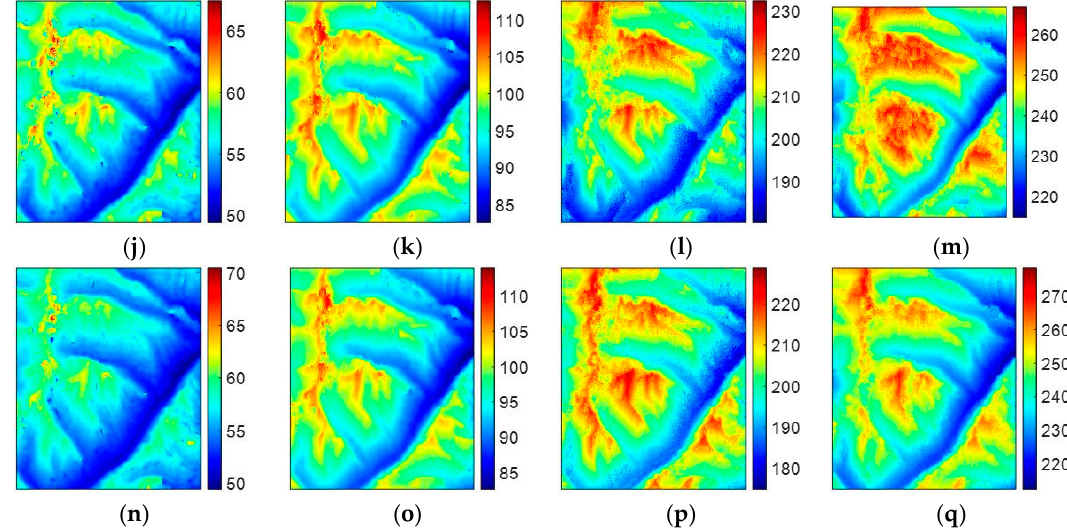
Figure 7. ( a ) Google Earth image of the study area. ( b – e ) ALOS PALSAR interferograms with di ff erent